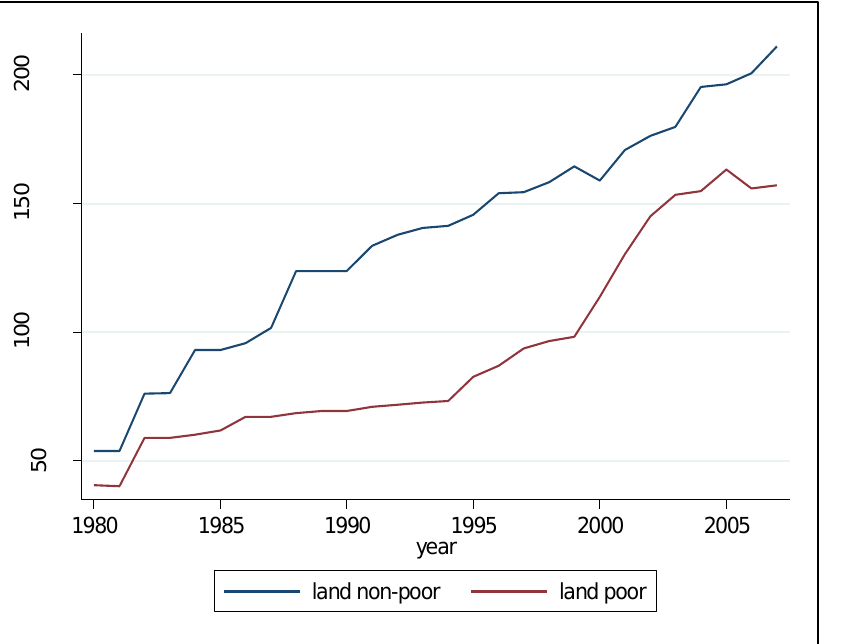
Figure A1.3. Total land holdings by household initial land endowment, San Jose